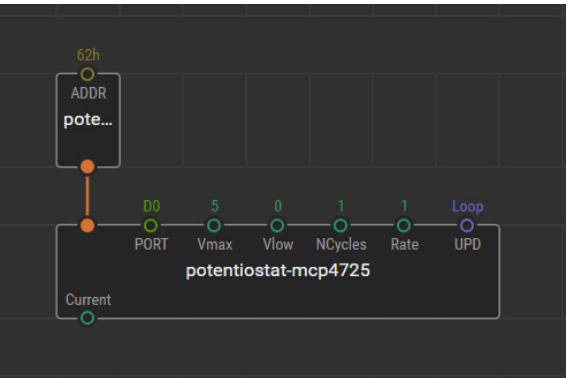
Figure A2. Example of the program for the potentiostat developed for XOD, visual programming for the easy application of the device.